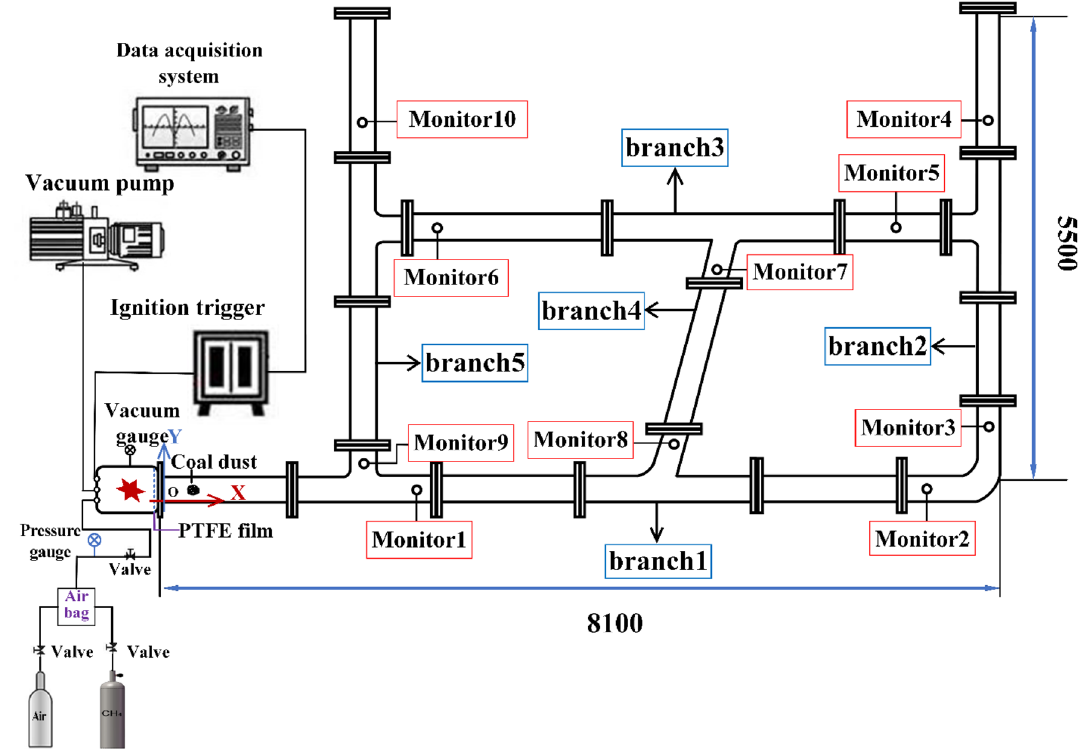
Figure 1. Experimental